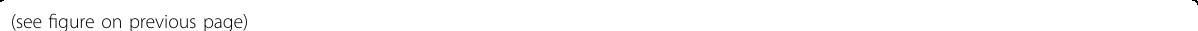
Fig. 4 Slug was a target gene of miR-125b-2-3p and positively correlated with the malignancy of OSCC. a MiR-125b-2-3p overexpression reduced the relative luciferase activity in Slug-WT. b Overexpressing or inhibiting miR-125b-2-3p changed the expression of Slug protein in SCC9 (left) and SCC15(right). c The expression of Slug in OSCC ( n = 319) and normal ( n = 32) tissues in TCGA database. d Kaplan – Meier analysis were employed to estimate the relation between Slug expression and overall survival of OSCC patients. e Representative images of Slug expression in the OSCC tumor and adjacent non-malignant tissue analyzed by immunohistochemical. f After transfecting si-Slug in SCC9 and SCC15, the expression of Slug, E-cadherin, N-cadherin, vimentin, and β -catenin was detected by western blot. g Si-Slug inhibited the migration(left) and invasion(right) in SCC9 and SCC15. * p < 0.05, ** p < 0.01, *** p <